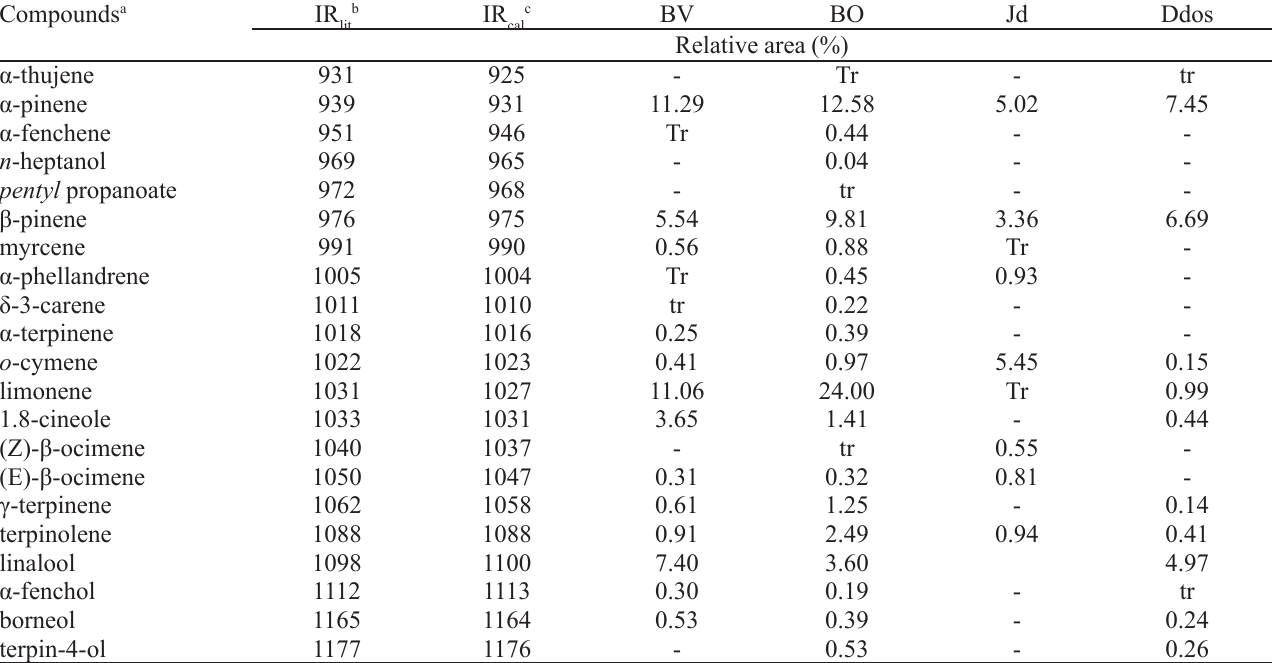
TABLE II - Compounds identified in the essential oil of Campomanesia adamantium leaves in different localities of Mato Grosso do Sul State, Brazil, during the fruit-bearing stage Compounds